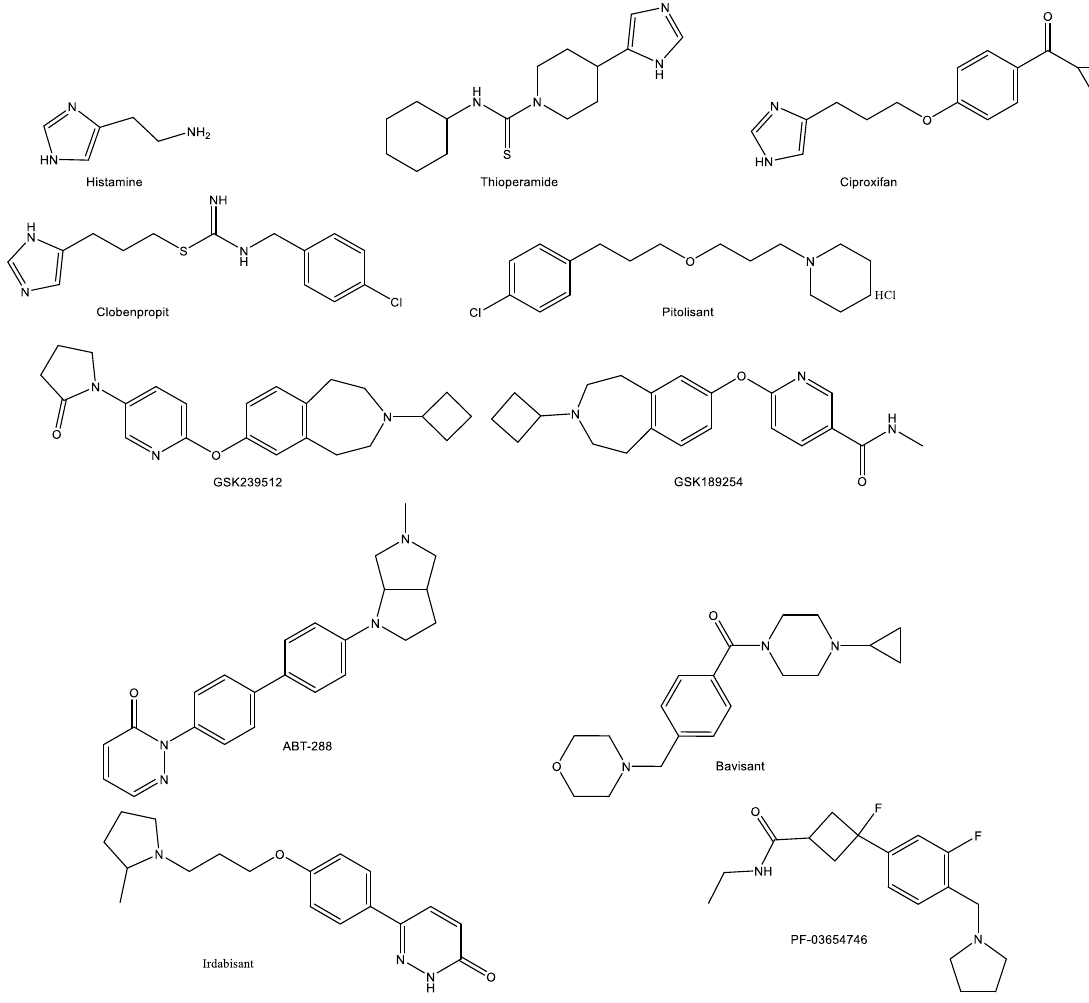
Figure 3. Structures of selected histamine-3 receptor antagonists in relation to histamine.